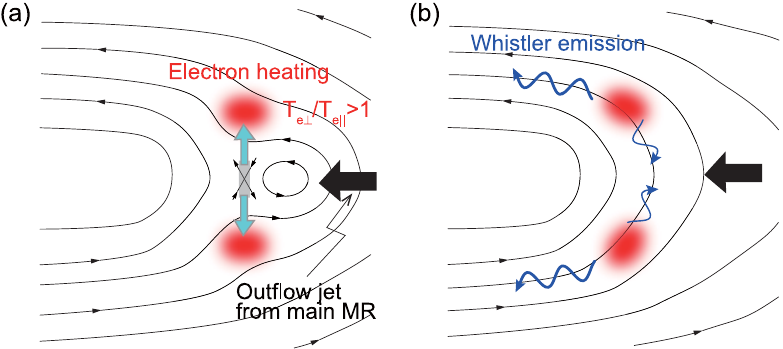
Figure 3. Schematic diagram showing the generation mechanism of a bursty emission of whistler waves in association with plasmoid collision. (a) When plasmoid collision occurs in the downstream edge of the main reconnection exhaust, a secondary reconnection takes place. The electron outflow jets (sky blue arrows) are generated in the z direction, leading to the perpendicular heating (red filled circles) of the electrons in the regions downstream of the secondary x-line. (b) As the plasmoid merging proceeds, the perpendicularly heated electrons move to the edge of the larger plasmoid (current sheet) and are compressed due to the magnetic tension force. As a result, the electrons become strongly magnetized so that a favorable condition for the whistler emission (blue arrows) is